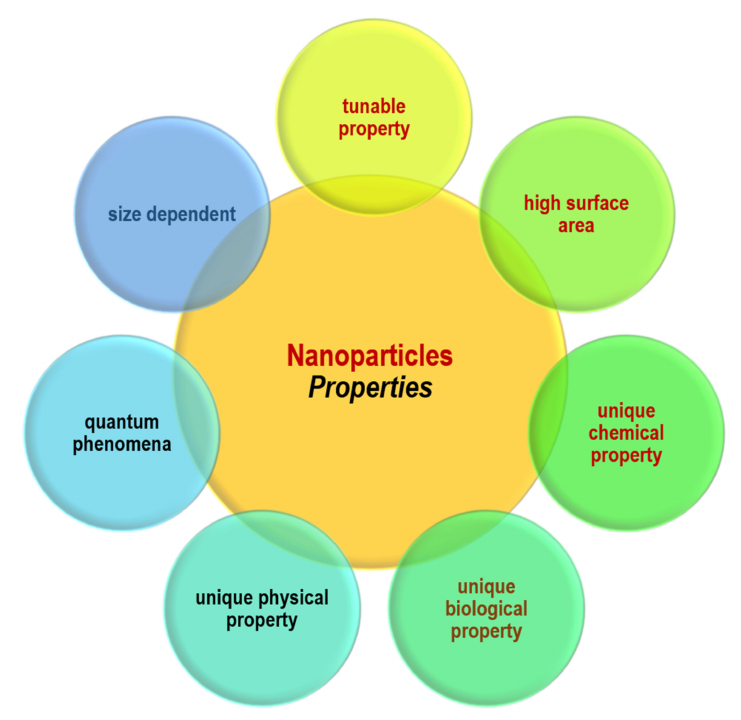
Figure 1. Unique properties of